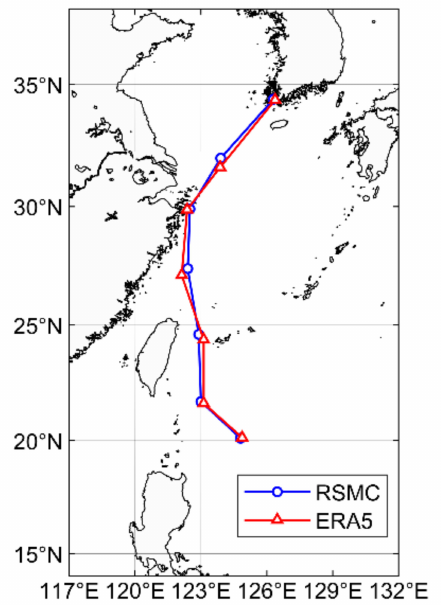
Figure 3. Comparison of Typhoon “MITAG” track (RSMC and